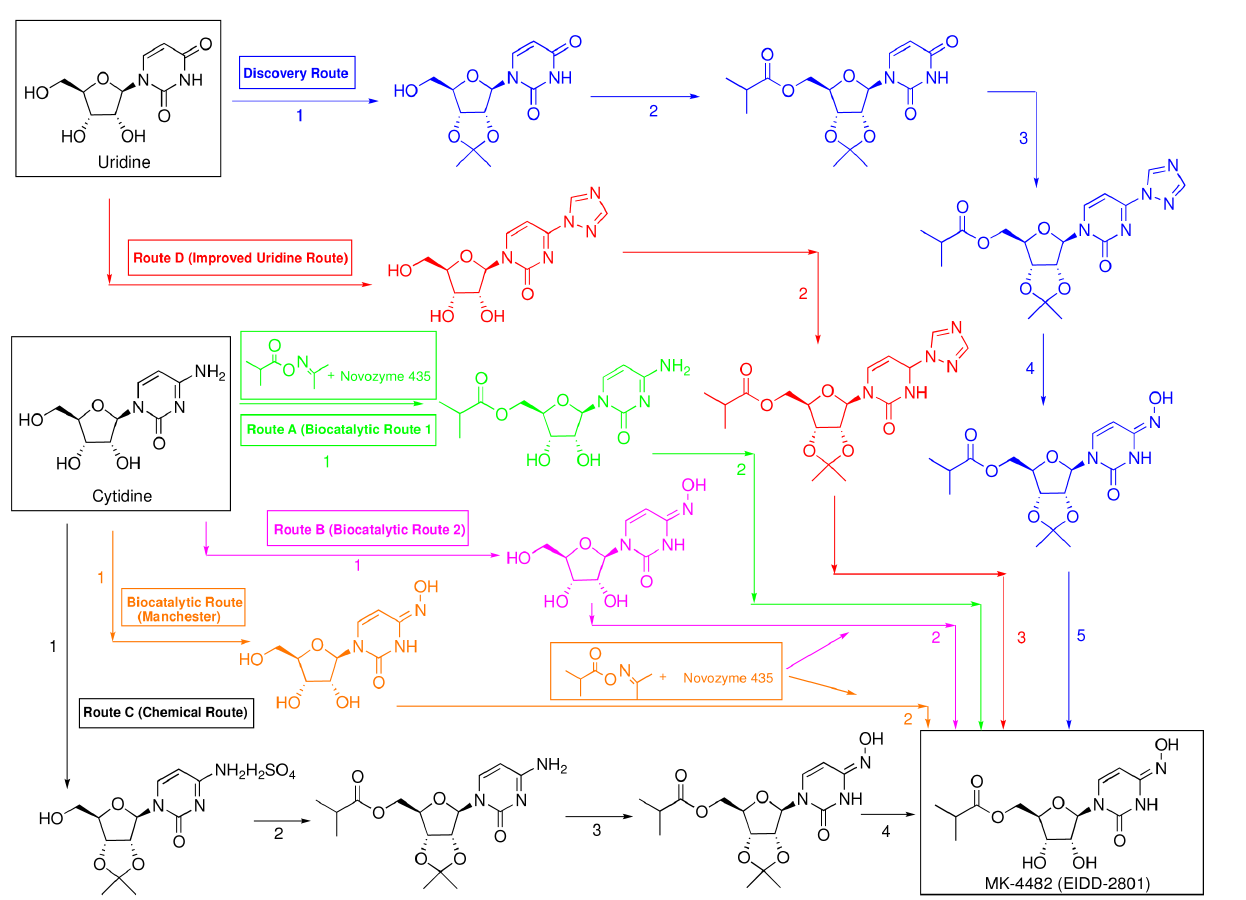
Figure 1. Modified uridine discovery route (D) and cytidine process routes (A, B, C,